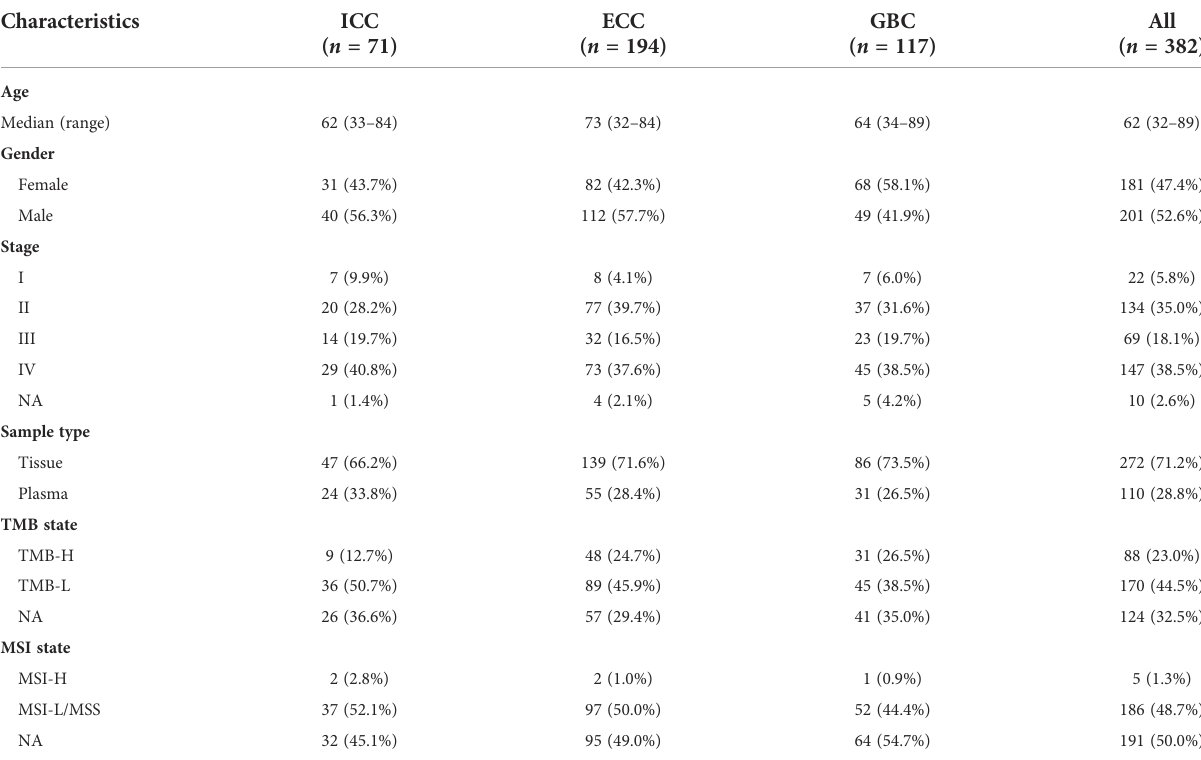
TABLE 1 Clinicopathologic characteristics of the study